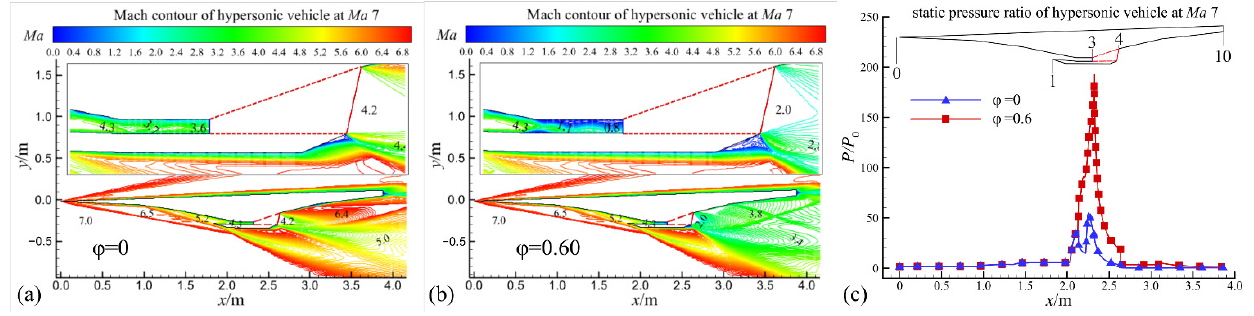
Figure 6. Mach contour and static pressure of the investigated hypersonic vehicle at Ma 7. ( a ) Exter- nal and internal flow at a fuel equivalence ratio of 0; ( b ) external and internal flow at a fuel equiva- lence ratio of 0.60; ( c ) static pressure distribution along the flow path at two different fuel equiva- lence ratios.